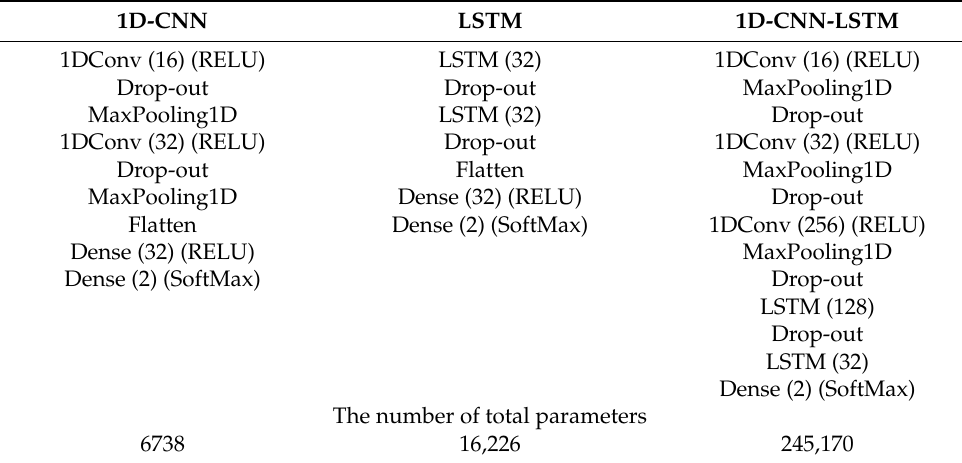
Table 3. The structural design for deep learning algorithms in the time domain.